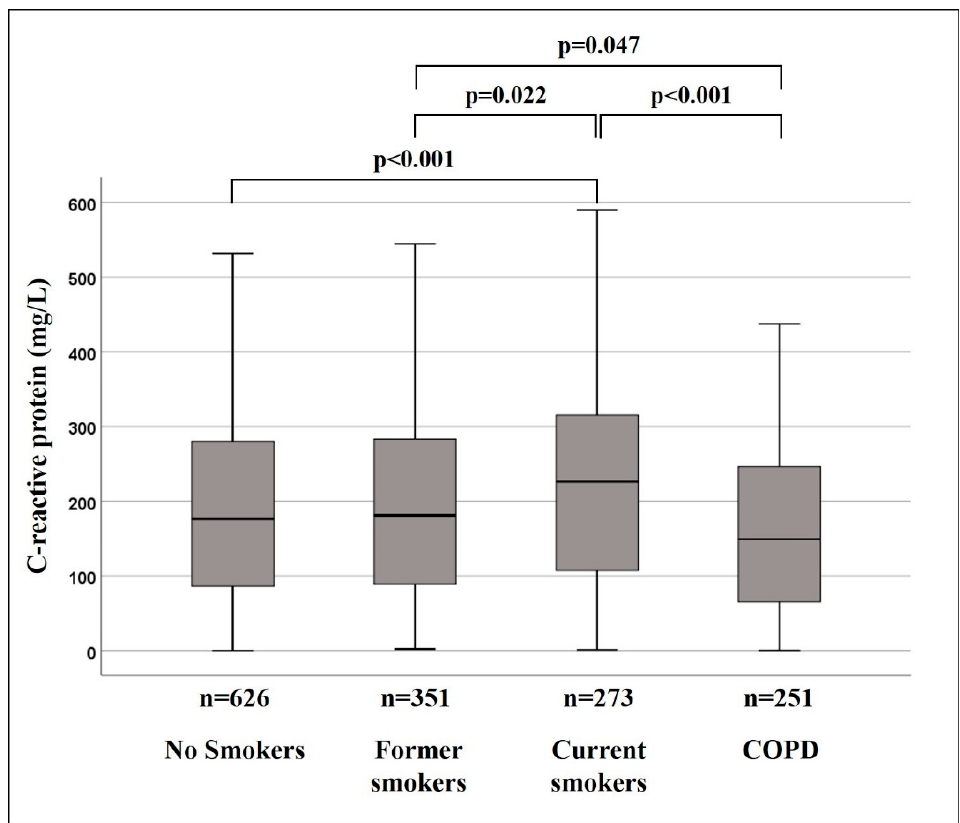
Figure 1. C-reactive protein levels of study cohorts.